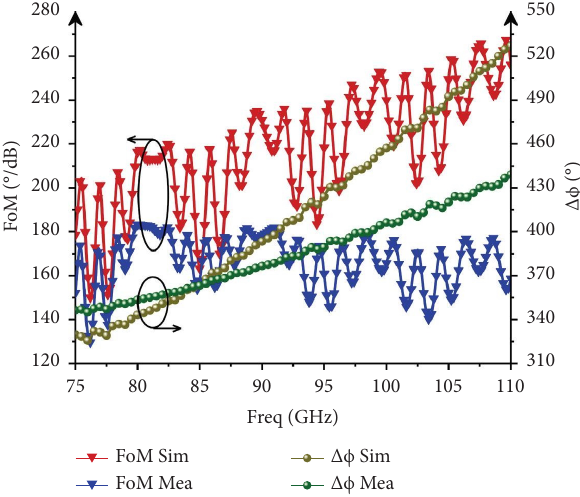
Figure 11: Te results of phase shift and Table 1: Comparison of previous works with this work.